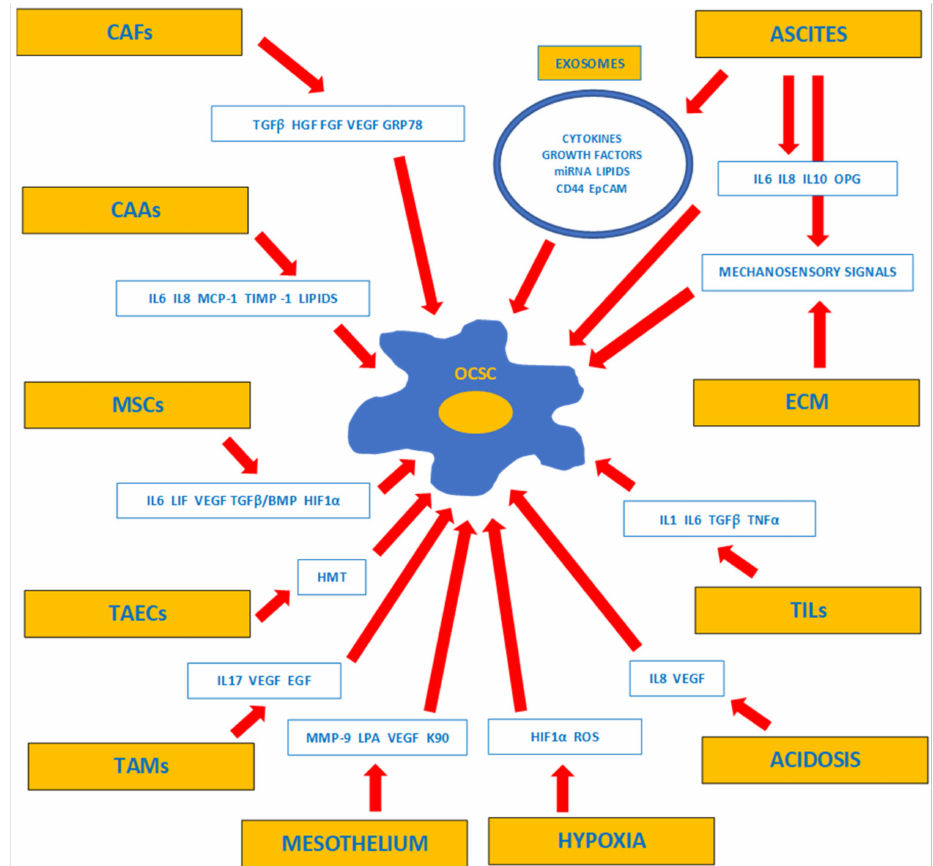
Figure 1. Secretory and mechanosensory signals identifying ovarian cancer-specific tumor microenvi- ronment (TME) and ovarian cancer stem cells’ (OCSCs) niche existing inside peritoneal cavity. Ascites is a unique microenvironment for OCSCs, which contains interleukins IL-6, IL-8, IL-10, vasculo- endothelial growth factor (VEGF), osteoprotegerin (OPG), exosomes (which transfer miRNAs, lipids, cytokines, growth factors, and OCSCs markers CD44 or EpCAM) able to pass signals between TME and OCSCs. Mechanosensory signals from ascites comprise shear and compression stress. Tension, stiffness and desmoplastic reaction are other mechanic stressors resulting from extracellular ma- trix (ECM) remodeling. Cancer-associated fibroblasts (CAFs) secrete transforming growth factor- β TGF- β which stimulates epigenetic changes promoting epithelial-mesenchymal transition (EMT) and metastases. CAFs also secrete hepatocyte growth factor (HGF), glucose-regulated protein 78 (GRP78) which augment invasiveness and chemo-resistance, as well as fibroblast growth factor (FGF) and VEGF both stimulating angiogenesis and chemo-resistance. Adipocyte-derived IL6, IL8, monocyte chemoattractant protein-1 (MCP-1) and tissue inhibitor of metalloproteinase-1 (TIMP-1) recruit cancer cells into the surface of the omentum. Cancer-associated adipocytes (CAAs) feed also OCSCs with lipids. LIF and IL-6 secreted by mesenchymal stem cells (MSCs) promote OCSC’s function. Up-regulation of TGF- β /bone morphogenic protein (BMP), VEGF and HIF-1 α contributes to angiogenesis and stimulates OCSCs phenotype. Secretion of IL-17, VEGF and epidermal growth factor (EGF) by tumor-associated macrophages (TAMs) promotes OCSCs phenotype, thus support- ing peritoneal carcinomatosis and implant formation. Pro-inflammatory cytokines (transforming growth factor- β (TGF- β ), tumor necrosis factor- α (TNF- α ), IL-1, IL-6) produced by activated tumor- infiltrating lymphocytes (TILs) enhance EMT. Tumor-associated endothelial cells (TAECs) secrete enzyme histone-lysine N-methyltransferase (HMT) which increases OCSC’s stemness. Mesothelium cells release soluble factors (such as lysophosphatidic acid (LPA), protein K90 and VEGF) into ascites which stimulate tumor aggressiveness and chemo-resistance. Hypoxia and acidosis in tumor TME are the stimulators of EMT and OCSCs stemness via hypoxia-inducible factor-1 α (HIF-1 α ), reactive oxygen species (ROS) and IL8, VEGF,